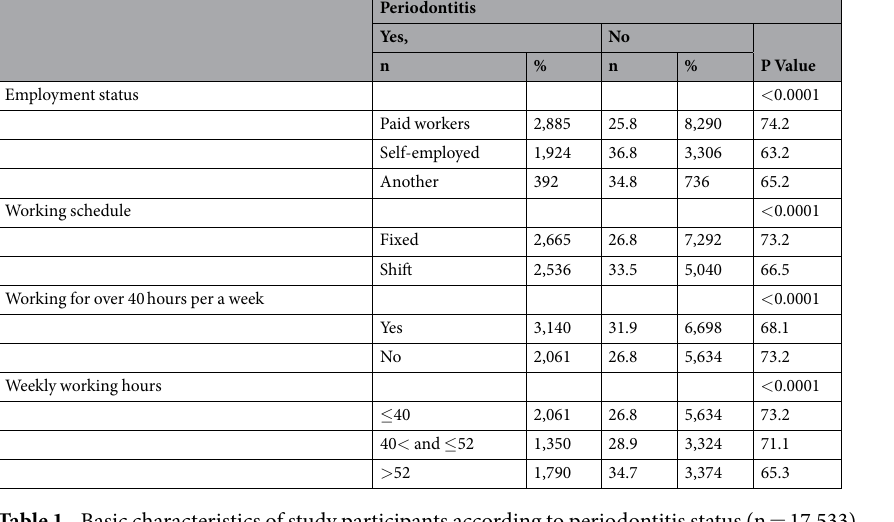
Table 1. Basic characteristics of study participants according to periodontitis status (n =